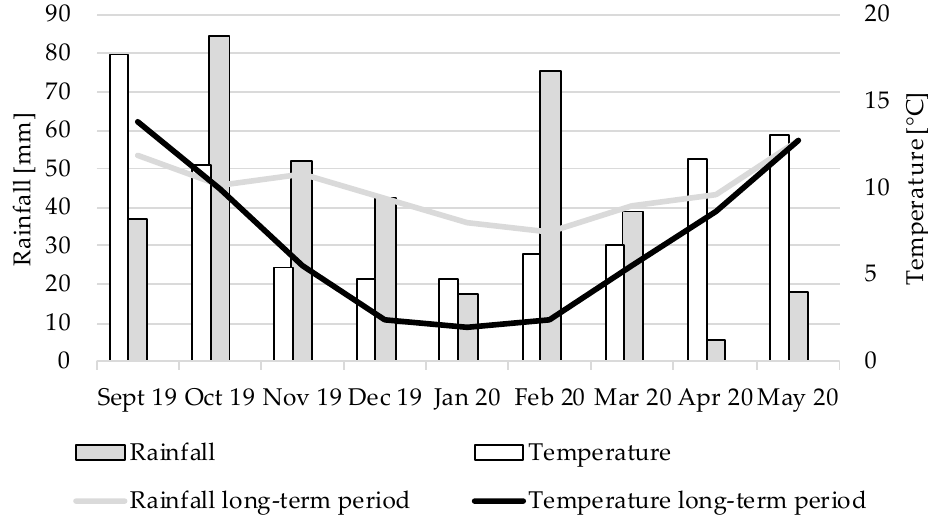
Figure 4. Monthly precipitation quantities and temperature over the 2019/2020 test period in comparison to the long-term mean precipitation and temperature at Campus Klein-Altendorf.